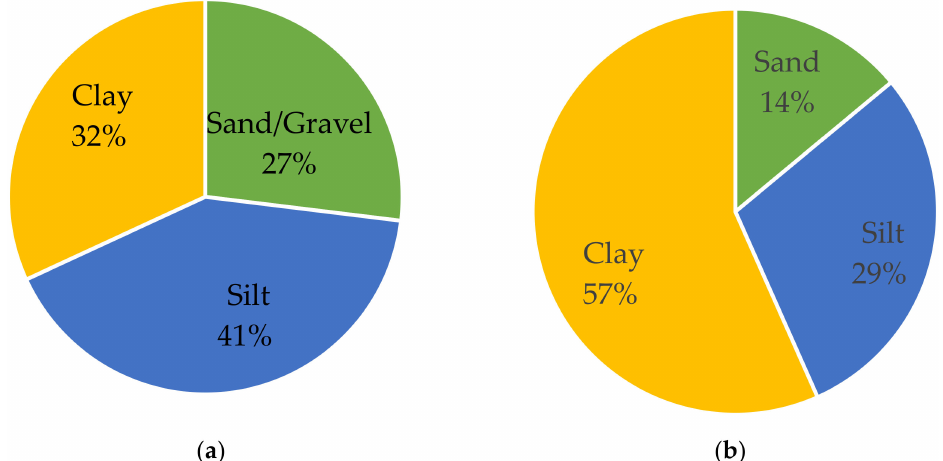
Figure 1. Mean value of particle size distribution of soft layers ( a ) Karakore soil (thickness of the soft layer h = 12.50 m) and ( b ) Ballina clay (thickness of soft layer h = 12.26